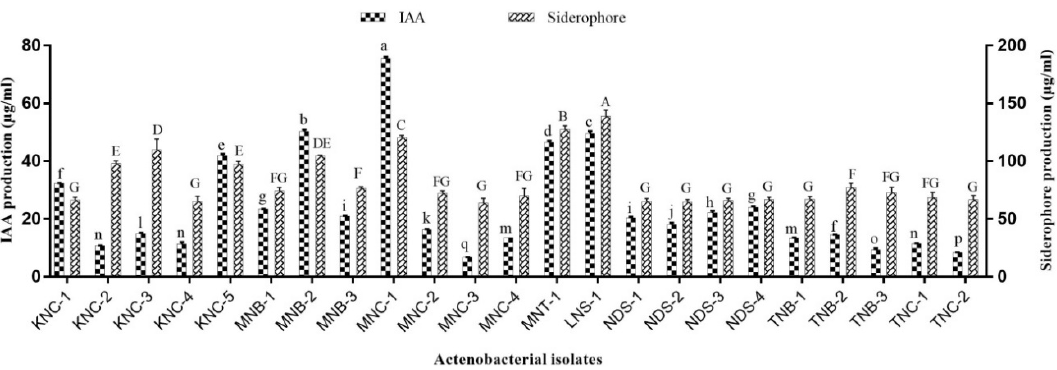
Figure 3. Indole acetic acid (IAA) and siderophore production by the isolated bacteria. Means (± standard deviations) within the same graphic followed by different small case letters from IAA production and capital letters for siderophore production are significantly different at p < 0.05.